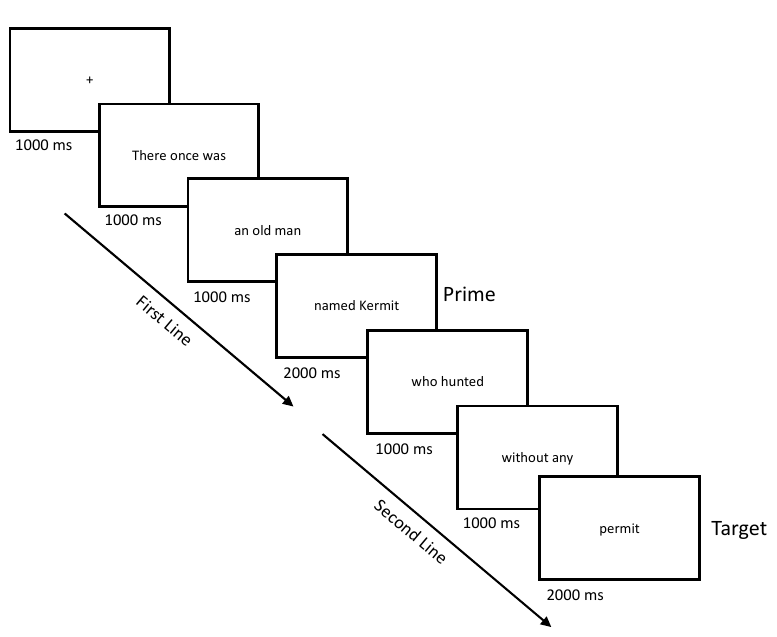
Figure 1. Presentation times in milliseconds of each region of the limerick couplets.